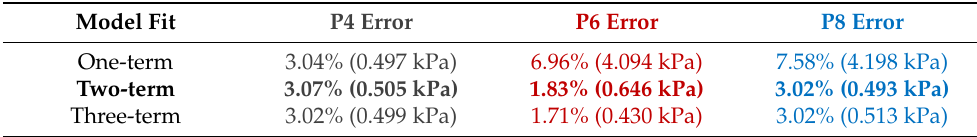
Table 3. Error analysis of Storakers hyperelastic material